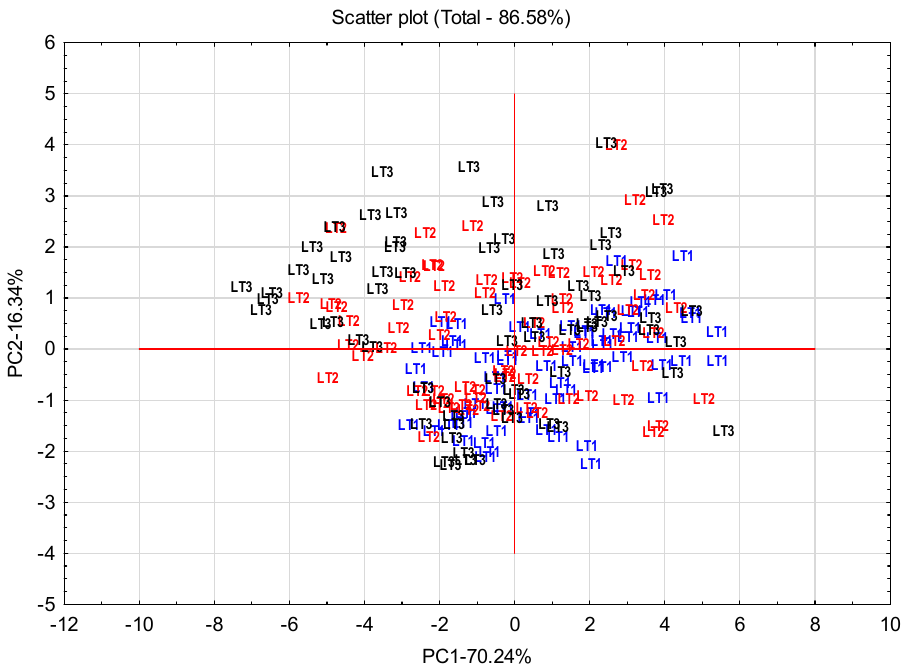
Figure 15. Based on the principal component analysis (PCA), configuration chart of observations illustrated in the system of the first two principal axes, showing interrelations among Narcissus poeticus plants lifted at different terms. Observations are presented in the category of lifting term (LT1–LT3).